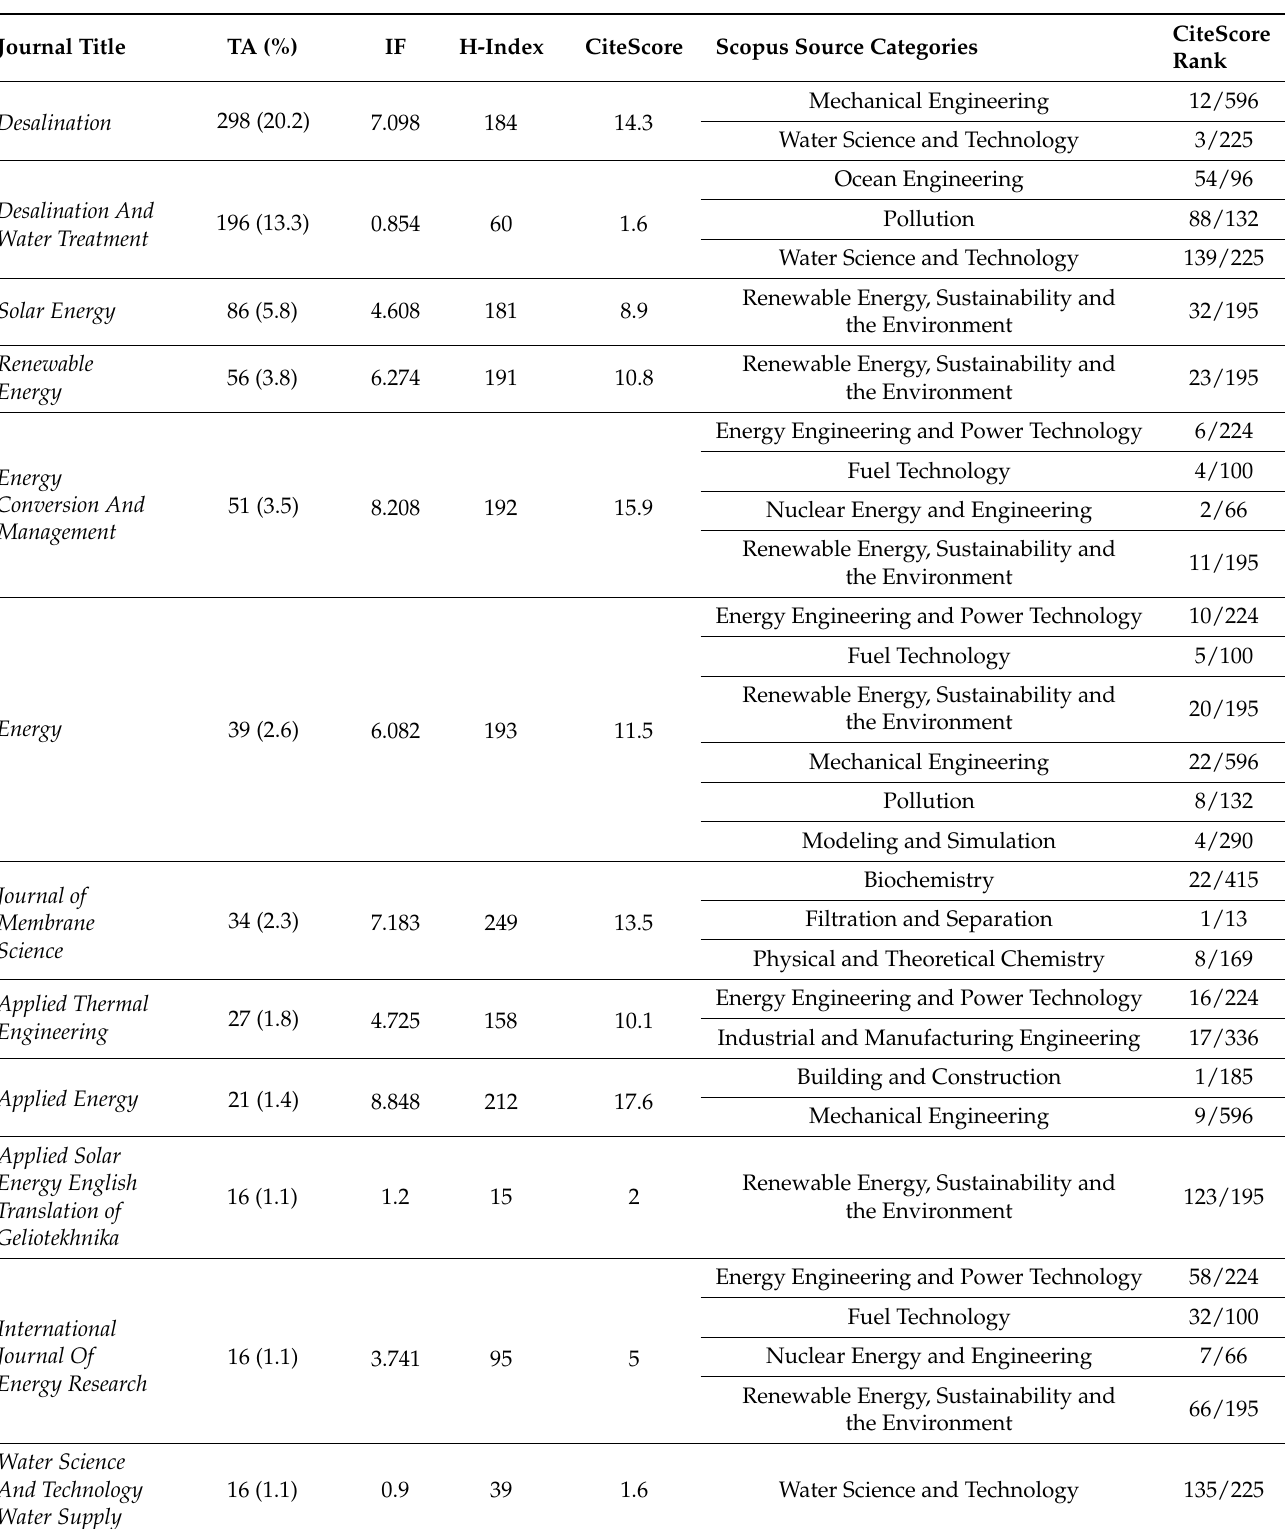
Table 3. The 12 most productive journals, their contribution in total publications, and journal